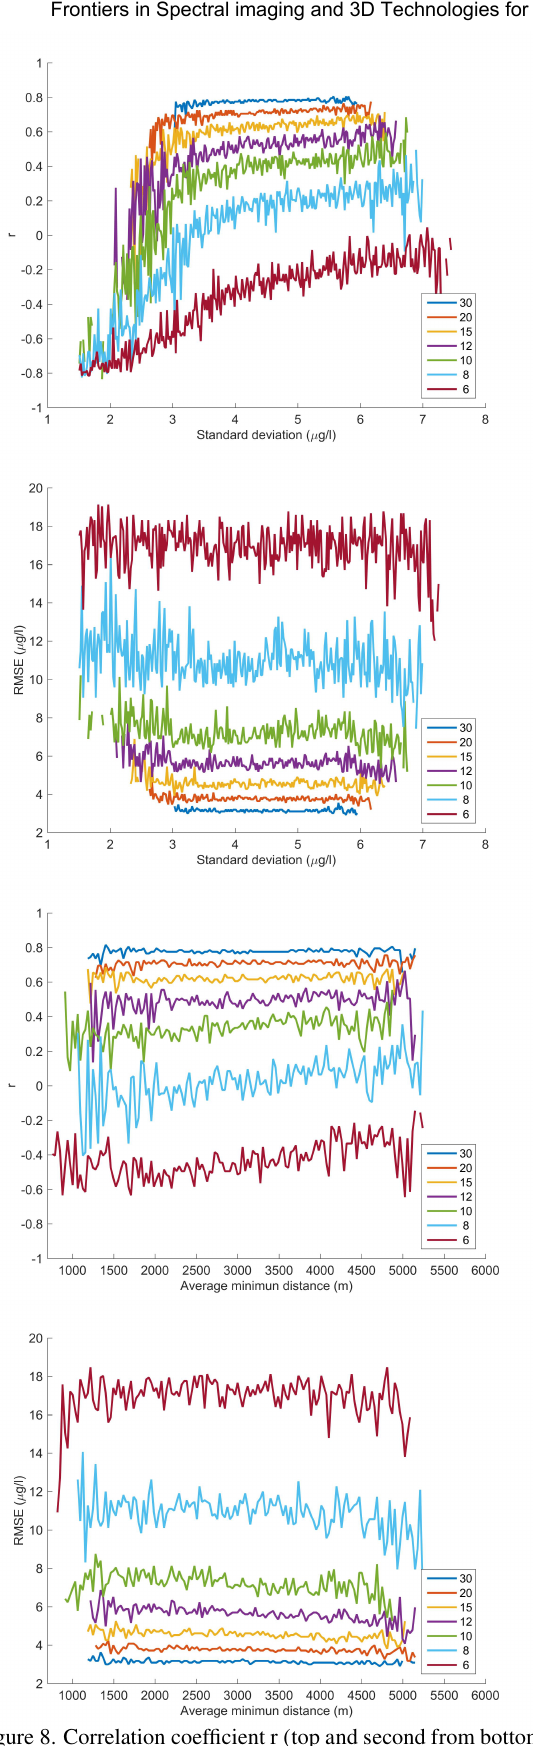
Figure 8. Correlation coefficient r (top and second from bottom Figure 9. Correlation coefficient r (top and second from bottom figures) and RMSE (second from top and bottom figures) for figures) and root mean square error (RMSE) (second from top different number of randomly selected measurements. All and bottom figures) for different number of wavelength bands as figures: 50000 random selection, probability level 0.05 and 5 variables. All figures: 12 randomly selected reference samples, bands. 50000 random selection and probability level